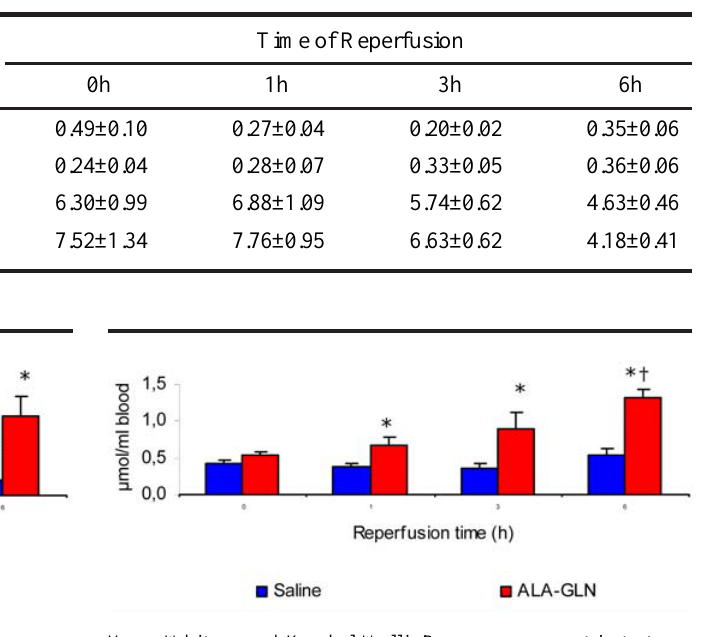
TABLE 1 - Blood pyruvate and glucose concentrations (µmol /ml of whole blood) in saline and Ala-Gln treated rats submitted to hind limb ischemia for 3 hours/reperfusion.